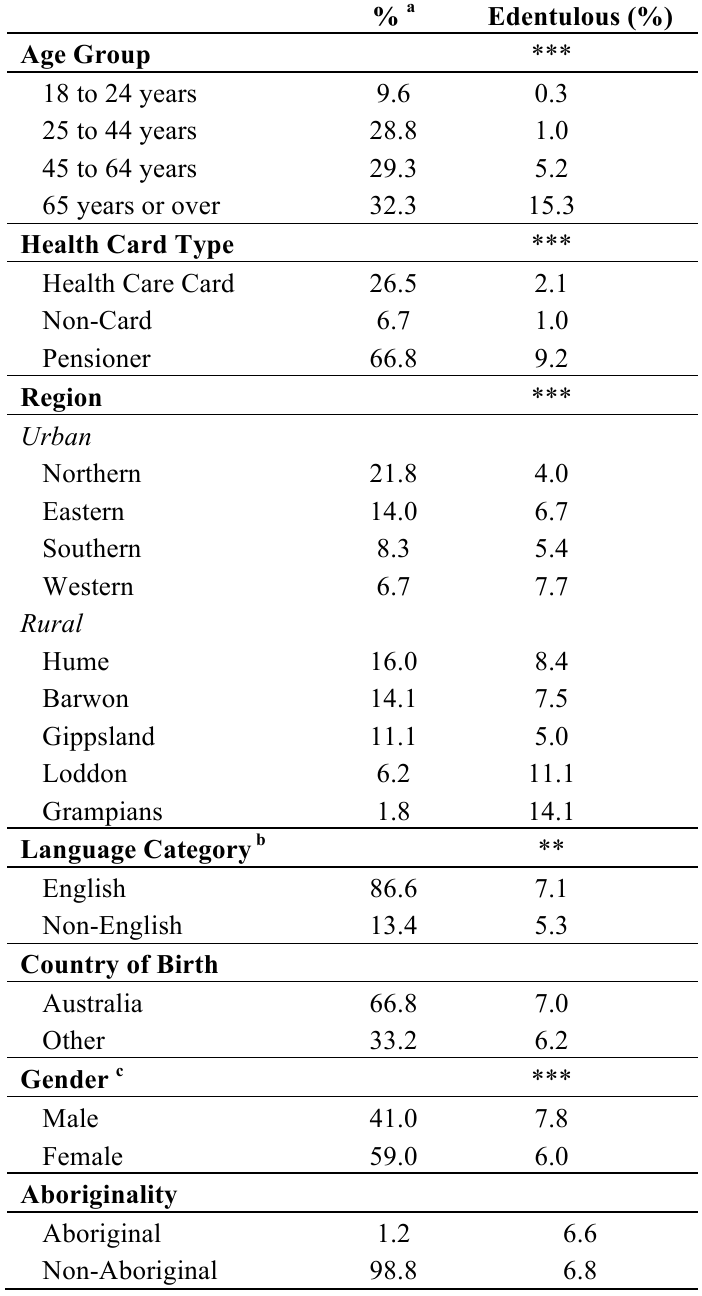
Table 1. Proportion of edentulous adults clients of public dental health services in Victoria by sociodemographic